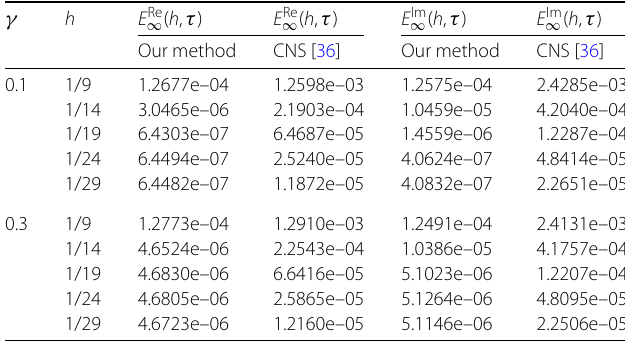
Table 6 (Example 6.2) E Re ∞ ( h , τ ) and E Im ∞ ( h , τ